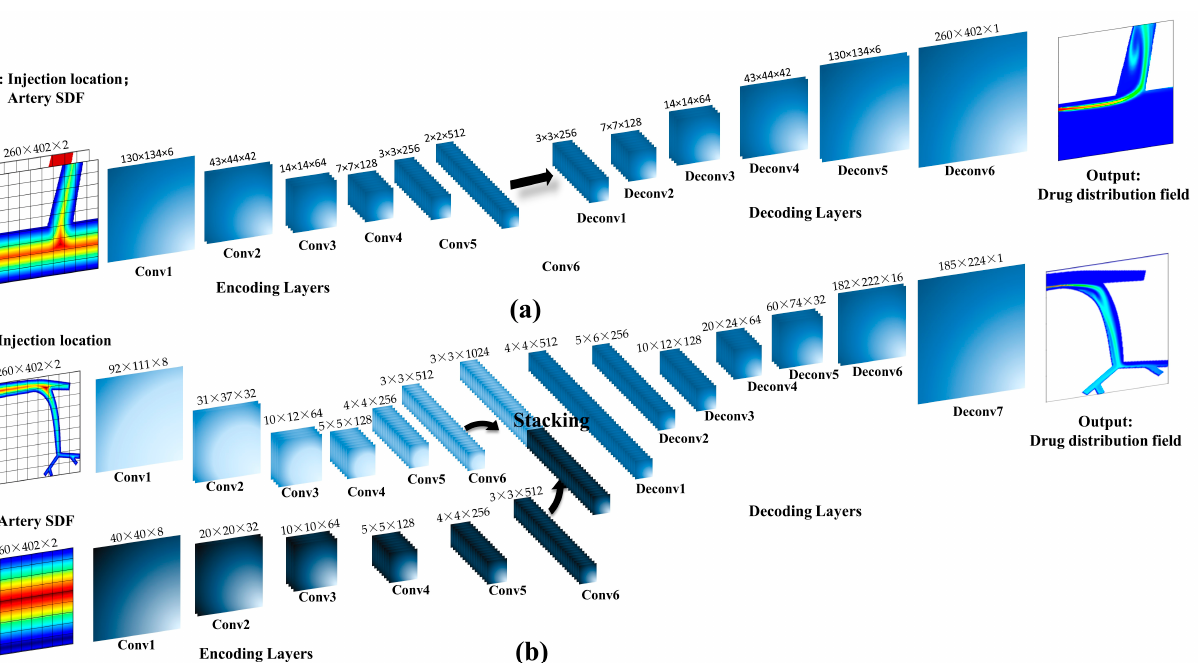
Table 1. Hyperparameters of the optimization algorithm: 𝜆 is the regularization coefficient. 𝛽 (cid:2869) , 𝛽 (cid:2870) and 𝜀 are the hyperparameters of the ADAM algorithm, 𝛼 denotes the learning rete. Batch Size λ 𝜷 𝟏 𝜷 𝟐 𝜺 𝜶 Bifurcated blood vessels